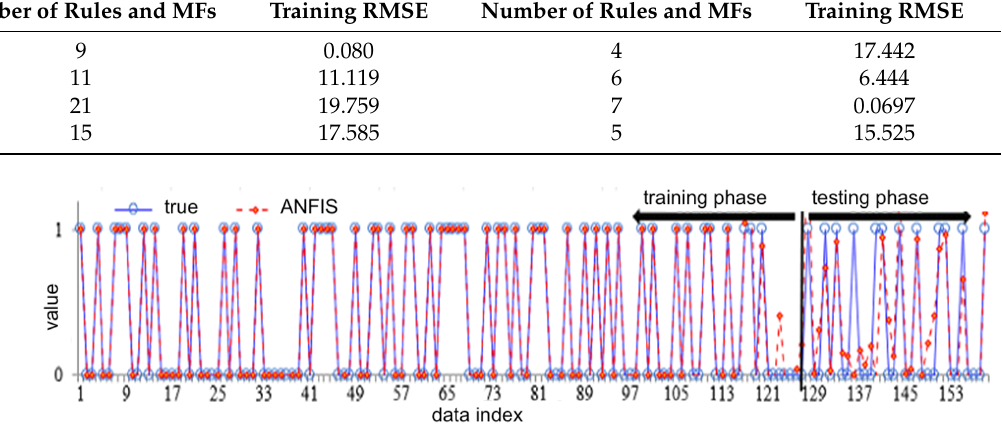
Table 6. ANFIS models with MFs and training errors; see abbreviations in Nomenclature.